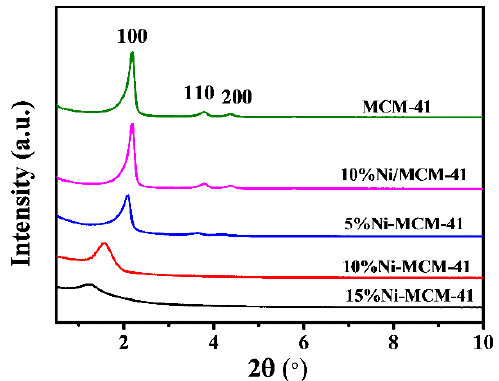
Figure 1. Low-angle XRD patterns of fresh Ni / MCM-41 and Ni-MCM-41 catalysts.